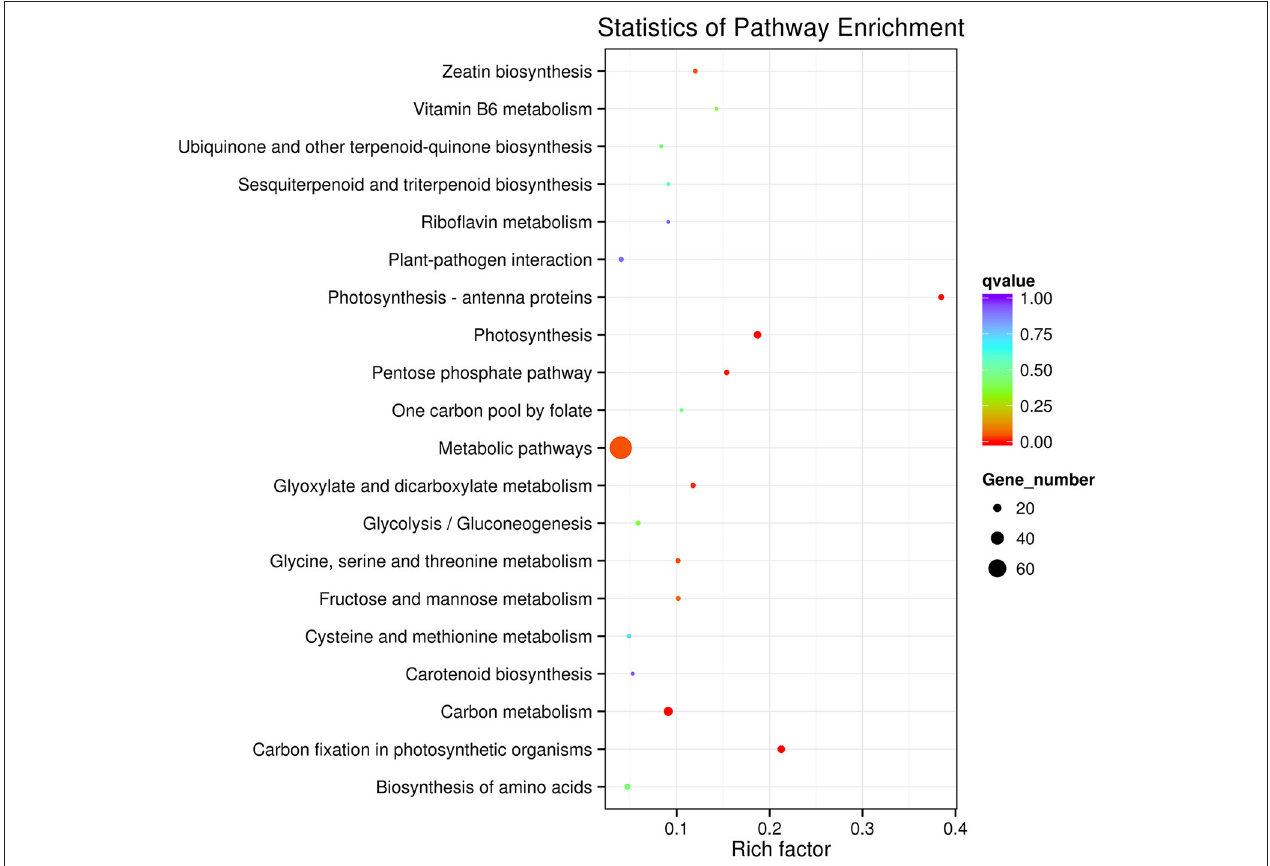
FIGURE 4 | KEGG pathway enrichment analysis of DEGs between Chill and Chill + EBR treatment. The left Y-axis shows the KEGG pathway. The X-axis shows the Rich factor. A high q -value is represented by blue and a low q- value is represented by red ( q <